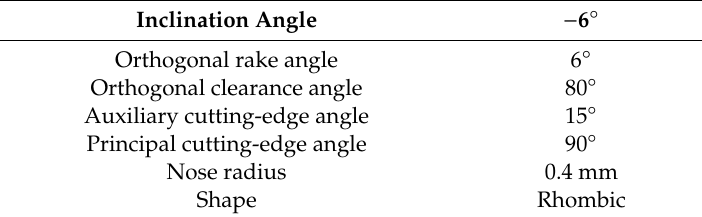
Table 3. Tool geometry of cutting